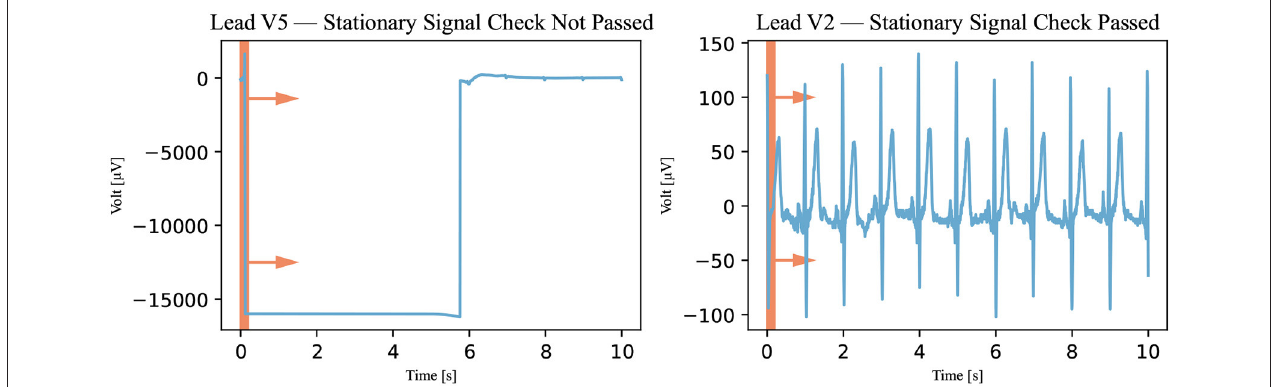
FIGURE 4 | Stationary signal check. The window, represented by the red rectangle, moved through the signal (Recording 1072620) in the direction of the arrows, and the signal was viewed through the window in this algorithm. If the signal was stationary in the window at a specific time, it was declared not passed. A not-passed signal is shown on the left and a signal that has passed is shown on the